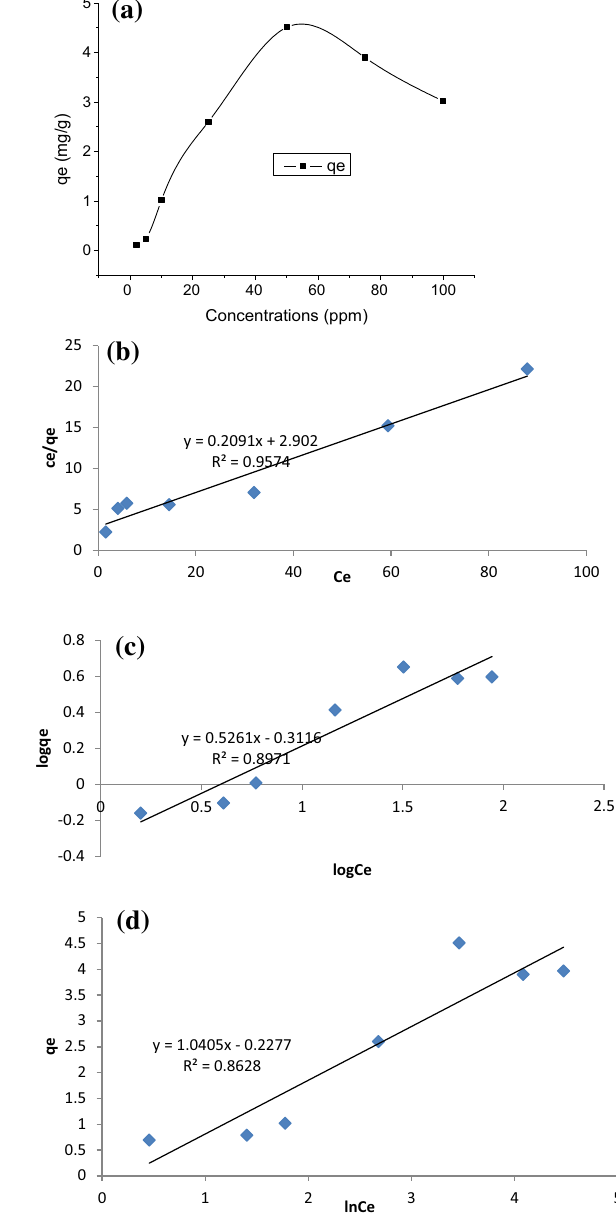
Fig. 3 a Effect of concentration on the sorption of BPA onto nFe b Langmuir isotherm plot for the sorption of BPA onto nFe 3 O 4 . c Fre- undlich isotherm plot for the sorption of BPA onto nFe 3 O 4 . d Temkin isotherm plot for the sorption of BPA onto nFe 3 O